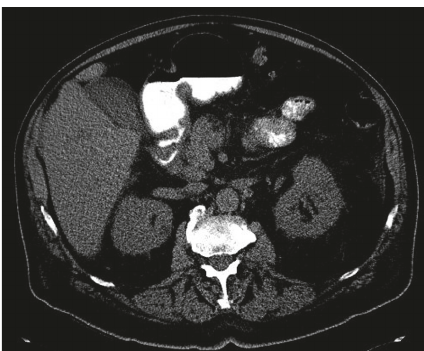
Figure 1: Axial unenhanced CT of the abdomen obtained at presen- tation shows a diffusely thickened and low attenuation gallbladder wall.